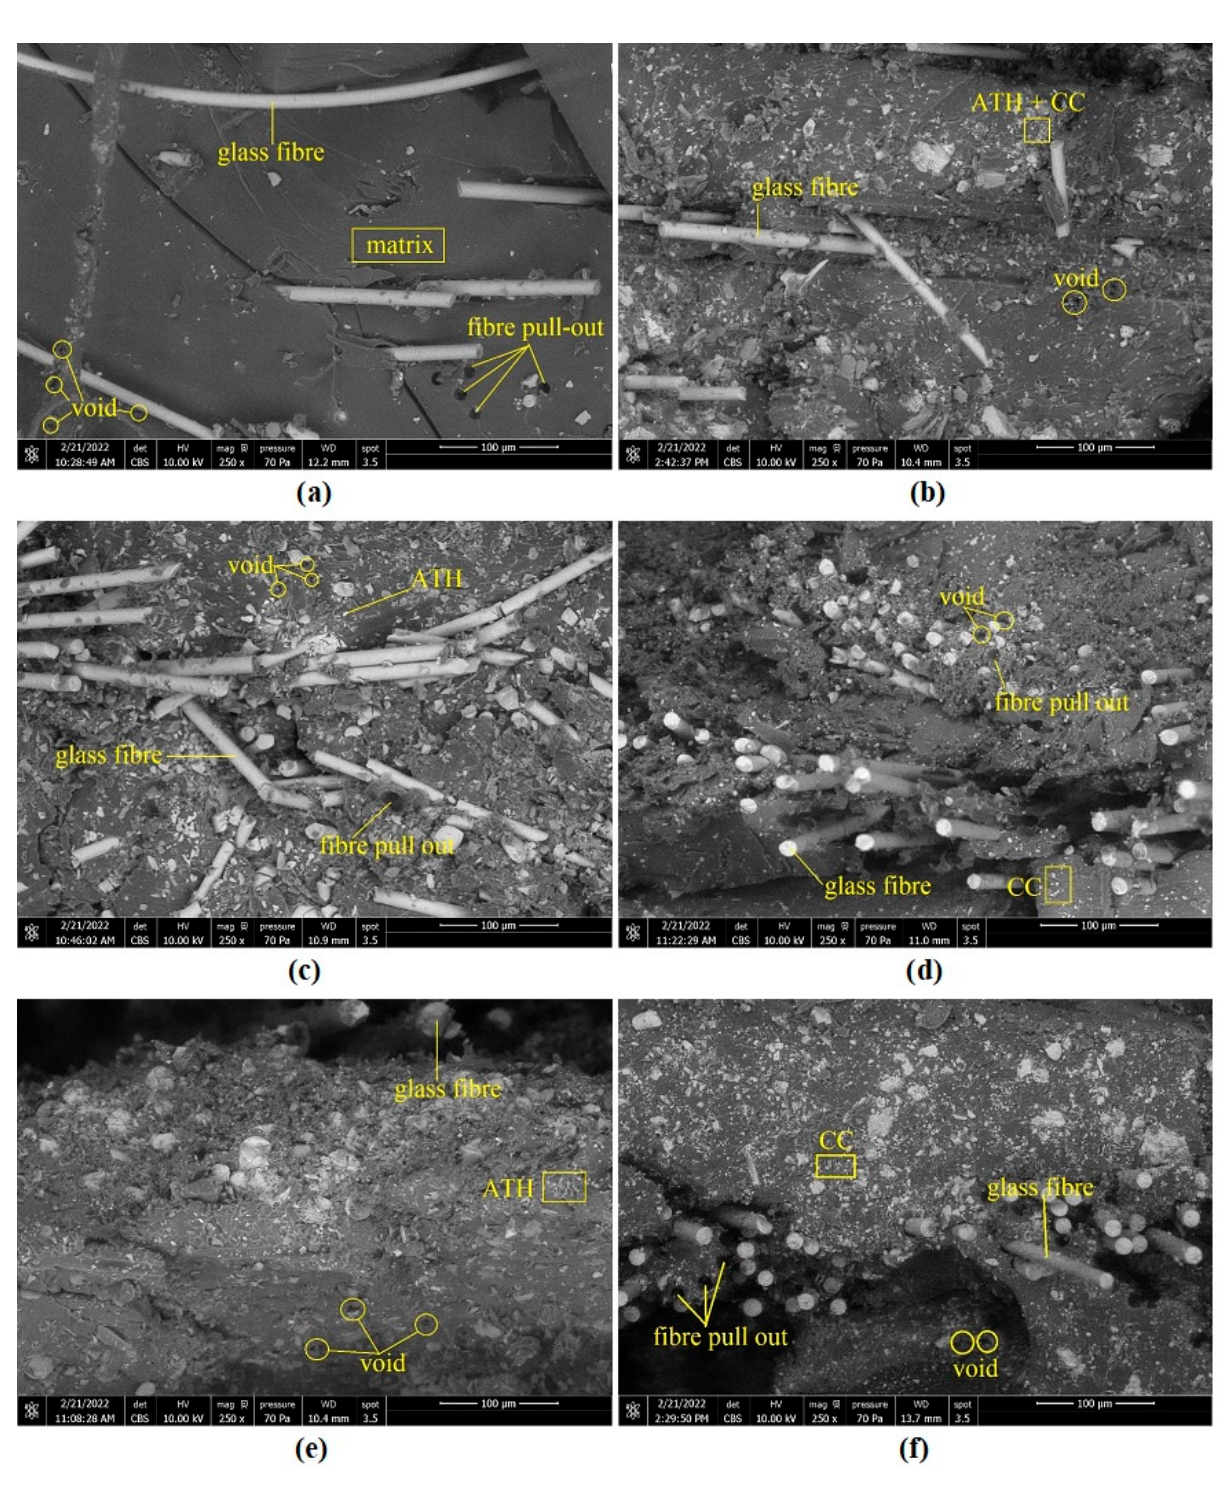
Figure 9. SEM micrographs of flexural fracture surfaces: ( a ) UP100, ( b ) CA15, ( c ) AT15, ( d ) CC15, ( e ) AT30, ( f ) CC30. ( e ) AT30, ( f )